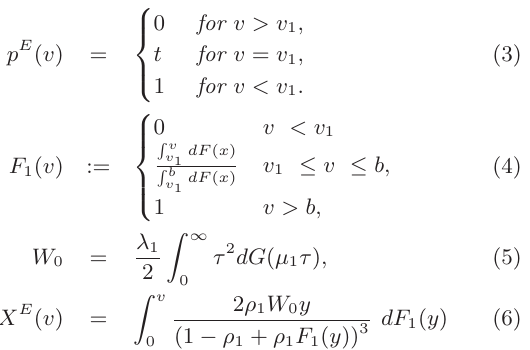
Figure 1: System with a HBF server and a FIFO